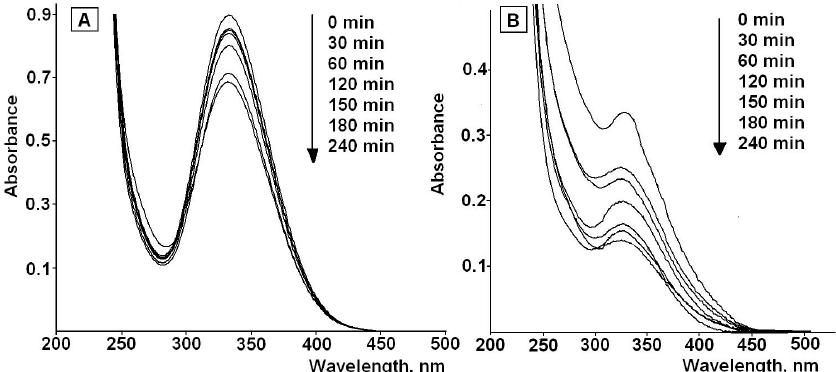
Figure 4. UV-VIS spectra of of LA ( A ) and LA in LA-MPMS composite ( B ) in water-ethanol (40%, v / v ) during the photodegradation process.